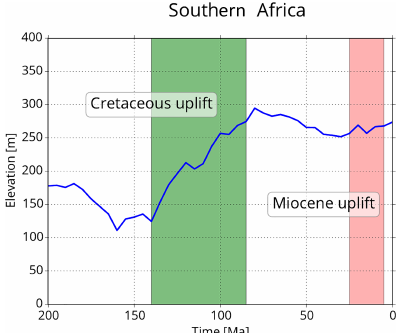
Figure 8. Southern African (sample point southern Africa east) uplift resulting from our models. While it successfully reproduces the Cretaceous uplift as described in previous work, uplift in the Miocene period remains comparatively small (see